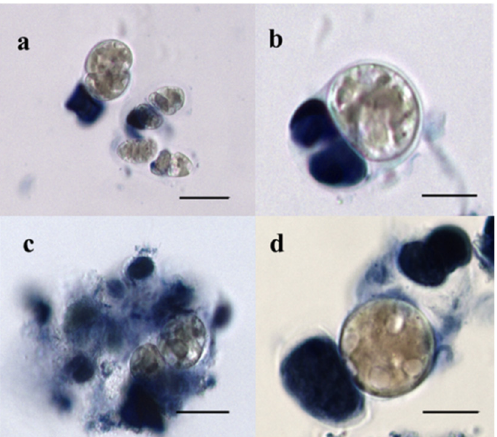
Figure 4. Detection of protoplasts by Evans blue staining. Dead protoplasts or cell fragments were stained by Evans blue. The survival rate of protoplasts was determined after Evans blue staining. ( a , c ): Scale bar = 20 µ m; ( b , d ): Scale bar = 10 µ